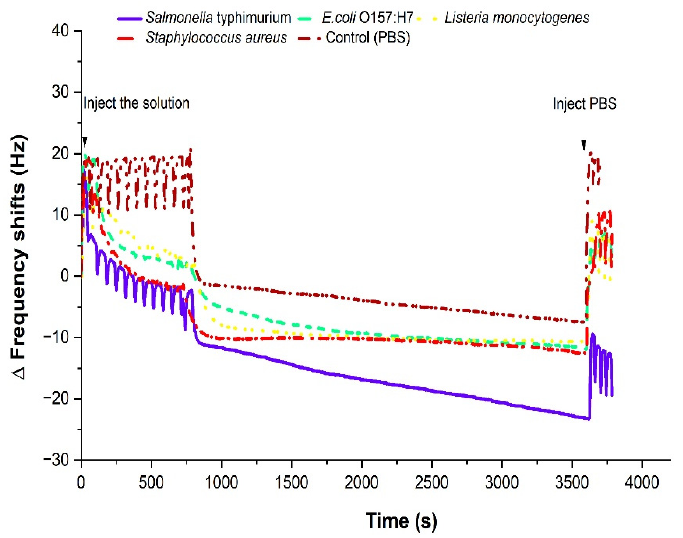
Figure 9. Frequency responses immediately after non- Salmonella such as E. coli O157:H7, Listeria monocytogenes , and Staphylococcus aureus . The concentration was 10 8 –10 9 CFU/mL. While we were expecting negligible frequency shifts from non- Salmonella samples, non-zero frequency shifts were observed for all negative samples due to the cross-reactivity of the antibody.